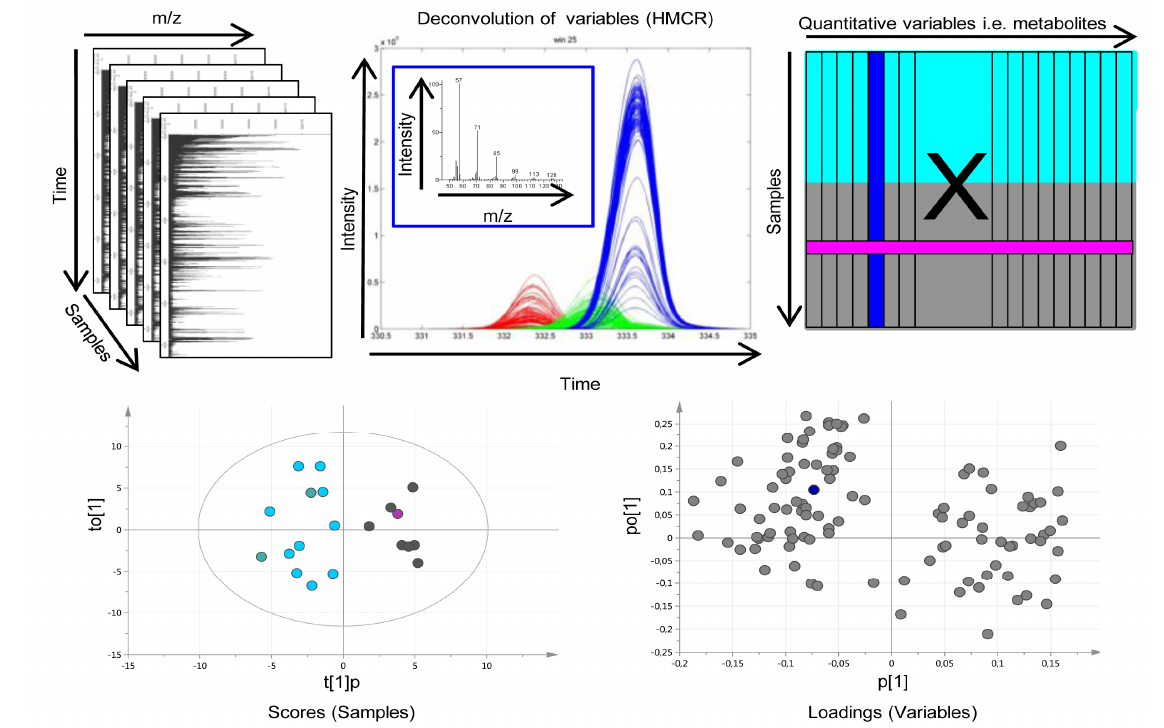
Figure 3. Overview of the metabolomic workflow. ( Upper panel . Left ) Raw